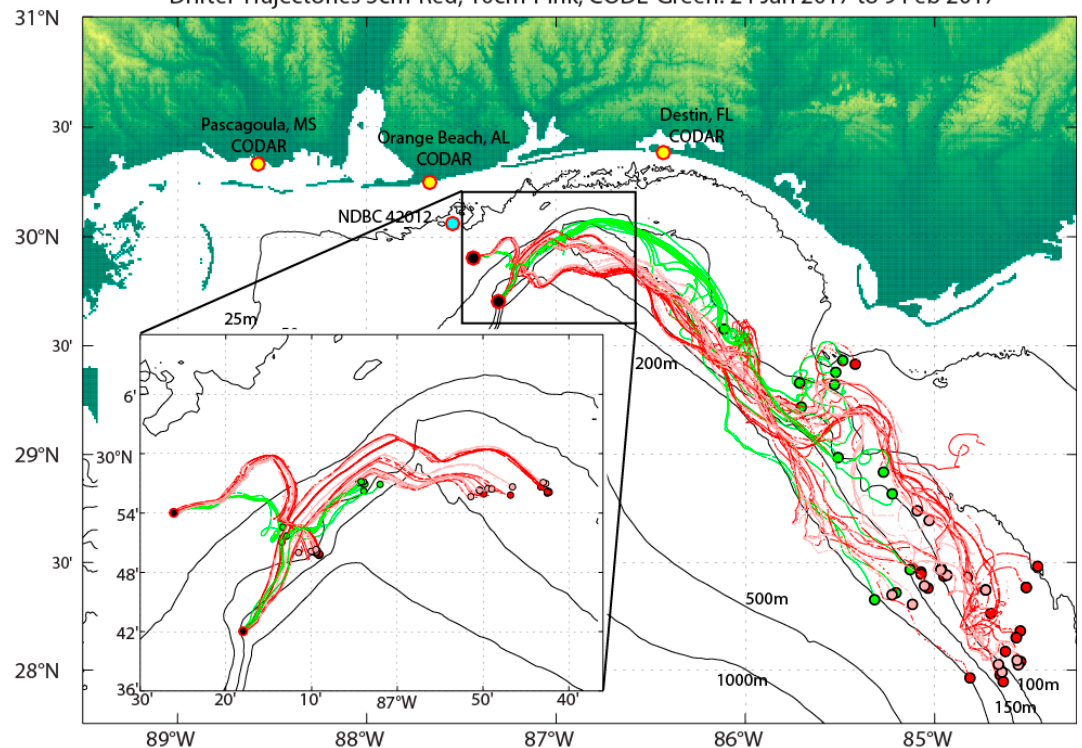
Figure 1. Map of the deployment region and drifter tracks for the first sixteen days of the experiment. Drifters were deployed at four drop points in a triangular pattern as described in Section 2.1, with each triangle centered at the black dots in the plot. The 5-cm drifter trajectories are shown in red, 10-cm drifters in pink, and the CODE-style drifters in green. The location of National Data Buoy Center (NDBC) buoy 42012 (cyan dot) is shown along with the HF radar antennae locations (yellow dots). The inset shows the drifter trajectories over their first three days.